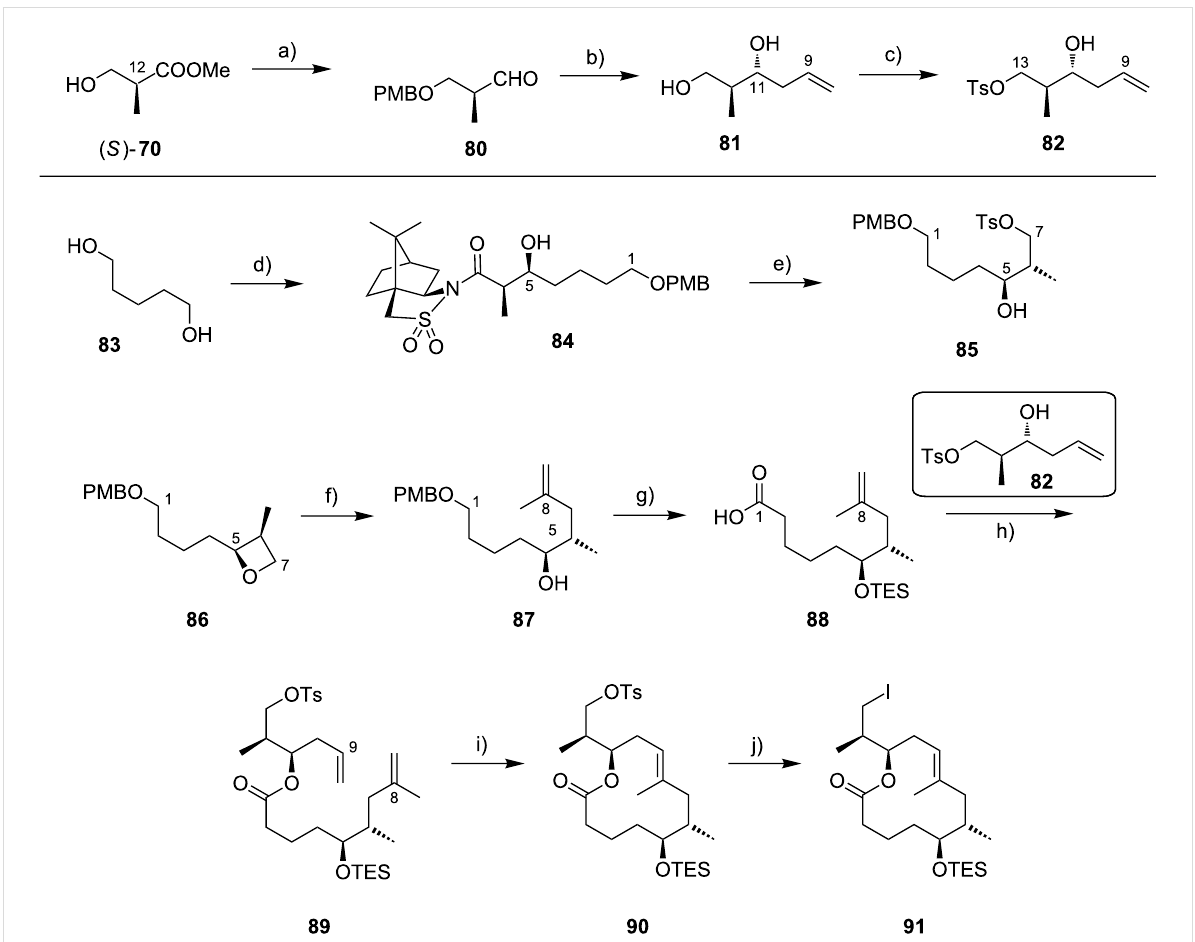
Scheme 7: Altmann’s synthesis of alkyl iodide 91 . Reagents and conditions: a) (i) PMB-trichloroacetimidate, TfOH, Et 2 O, rt, 58%. (ii) DIBAL-H,